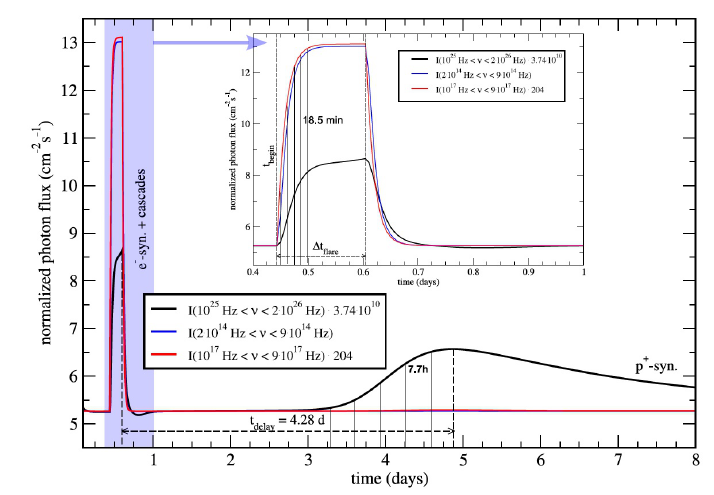
Figure 10. Multi-band (optical = blue, X-ray = red, γ -ray = black) light curves from a lepto-hadronic model with gradual, stochastic acceleration of particles. The acceleration time scale for protons is substantially longer than for electrons, leading to a delayed γ -ray orphan flare due to proton-synchrotron emission. From [101]. Reproduced with permission from